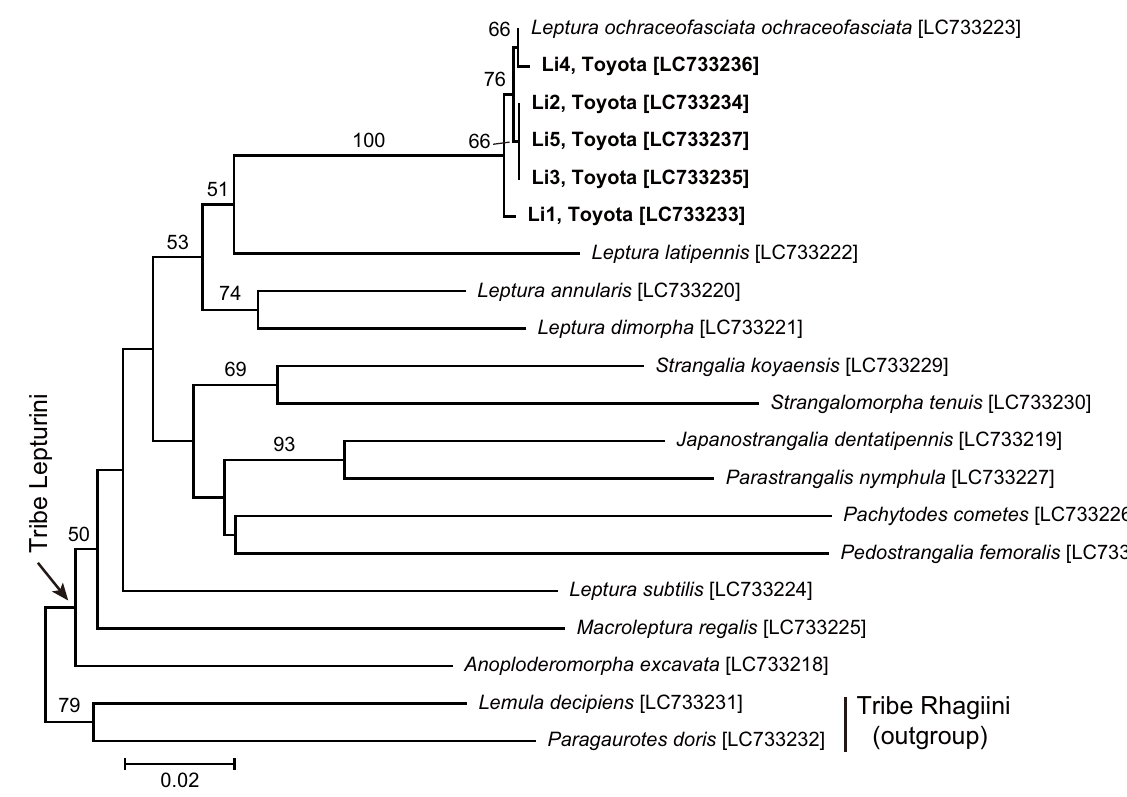
Fig 3. A neighbor-joining phylogenetic tree of Lepturinae constructed using DNA sequences of the COI gene (532 bps). Bootstrap values (1000 replicates) of 50% or higher are shown at the nodes. Sequence accession numbers are presented in brackets. For larval specimens, the individual ID and collection locality are indicated in